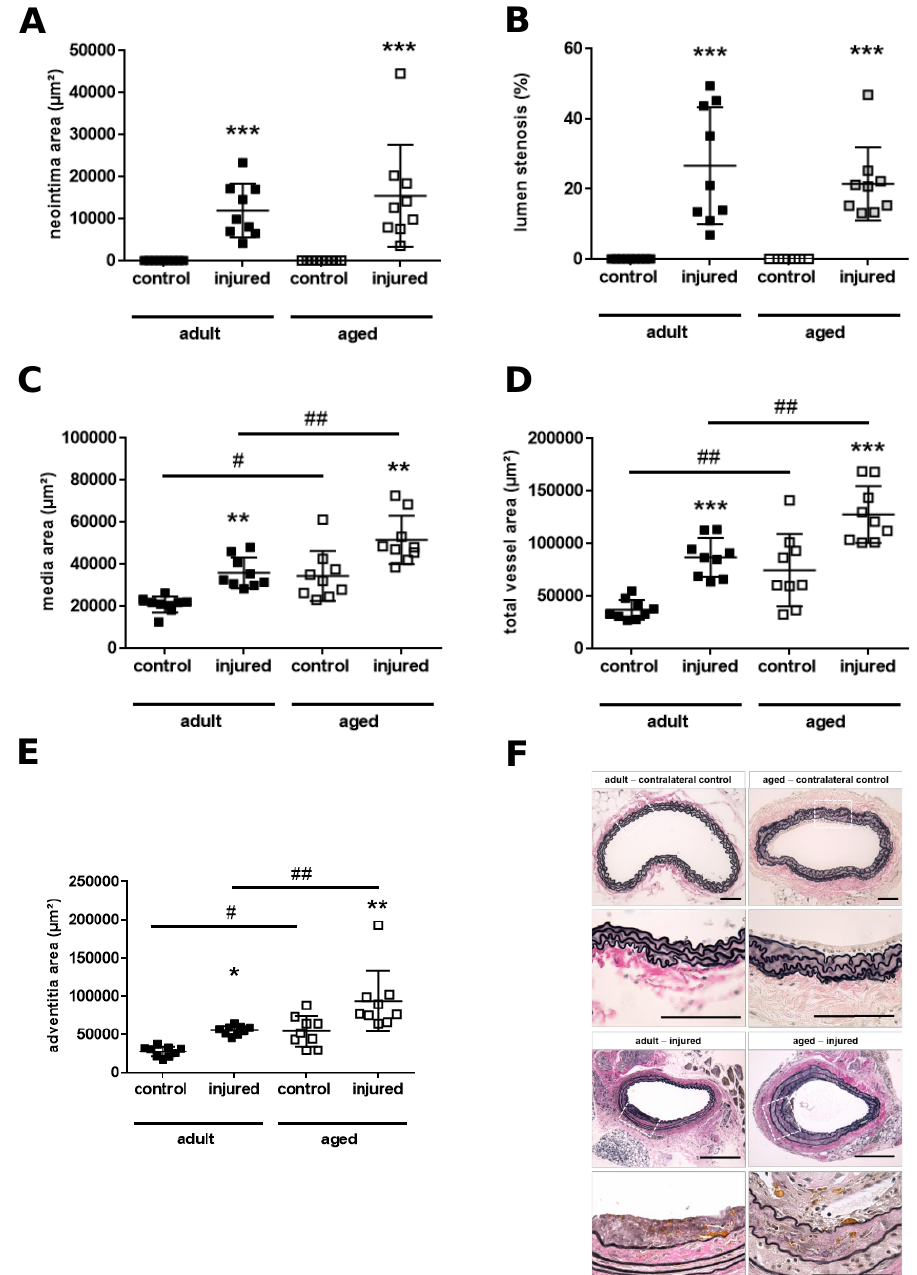
Figure 2. Neointima formation in adult and middle-aged mice. Vascular injury was induced at the carotid artery of C57BL6 / JRj WT mice aged 16 weeks (adult; n = 9) or 52 weeks (middle-aged; n = 9). The neointima area ( A ), lumen stenosis ( B ), media area ( C ), total vessel area ( D ) and adventitia area ( E ) were quantified on at least three Verhoe ff ’s elastica (VES)-stained para ffi n cross-sections through the injured carotid artery as well as the contralateral, uninjured artery (control), and results averaged per mouse. Individual mean values per mouse and the mean ± SD are shown. * p < 0.05, ** p < 0.01 and *** p < 0.001 vs. controls and # p < 0.05 and ## p < 0.01 vs. adult mice (as determined by the Kruskall–Wallis, followed by Dunn’s multiple comparisons test ( A , B , E ) or one-way ANOVA, followed by Sidak’s multiple comparisons test ( C , D ). Representative images in adult and middle-aged mice are shown in ( F ). Size bars represent 100 µ